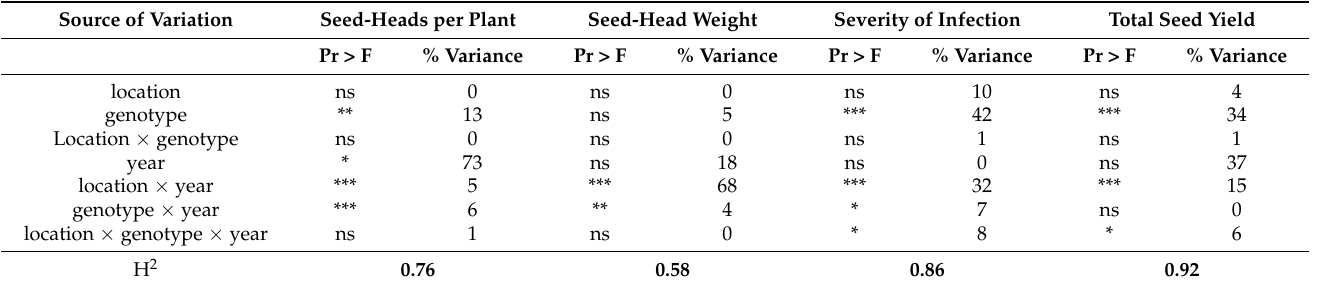
Table 2. Significance levels, percentage of the variance explained by the different sources of variation, and broad-sense heritability for variables measured in the